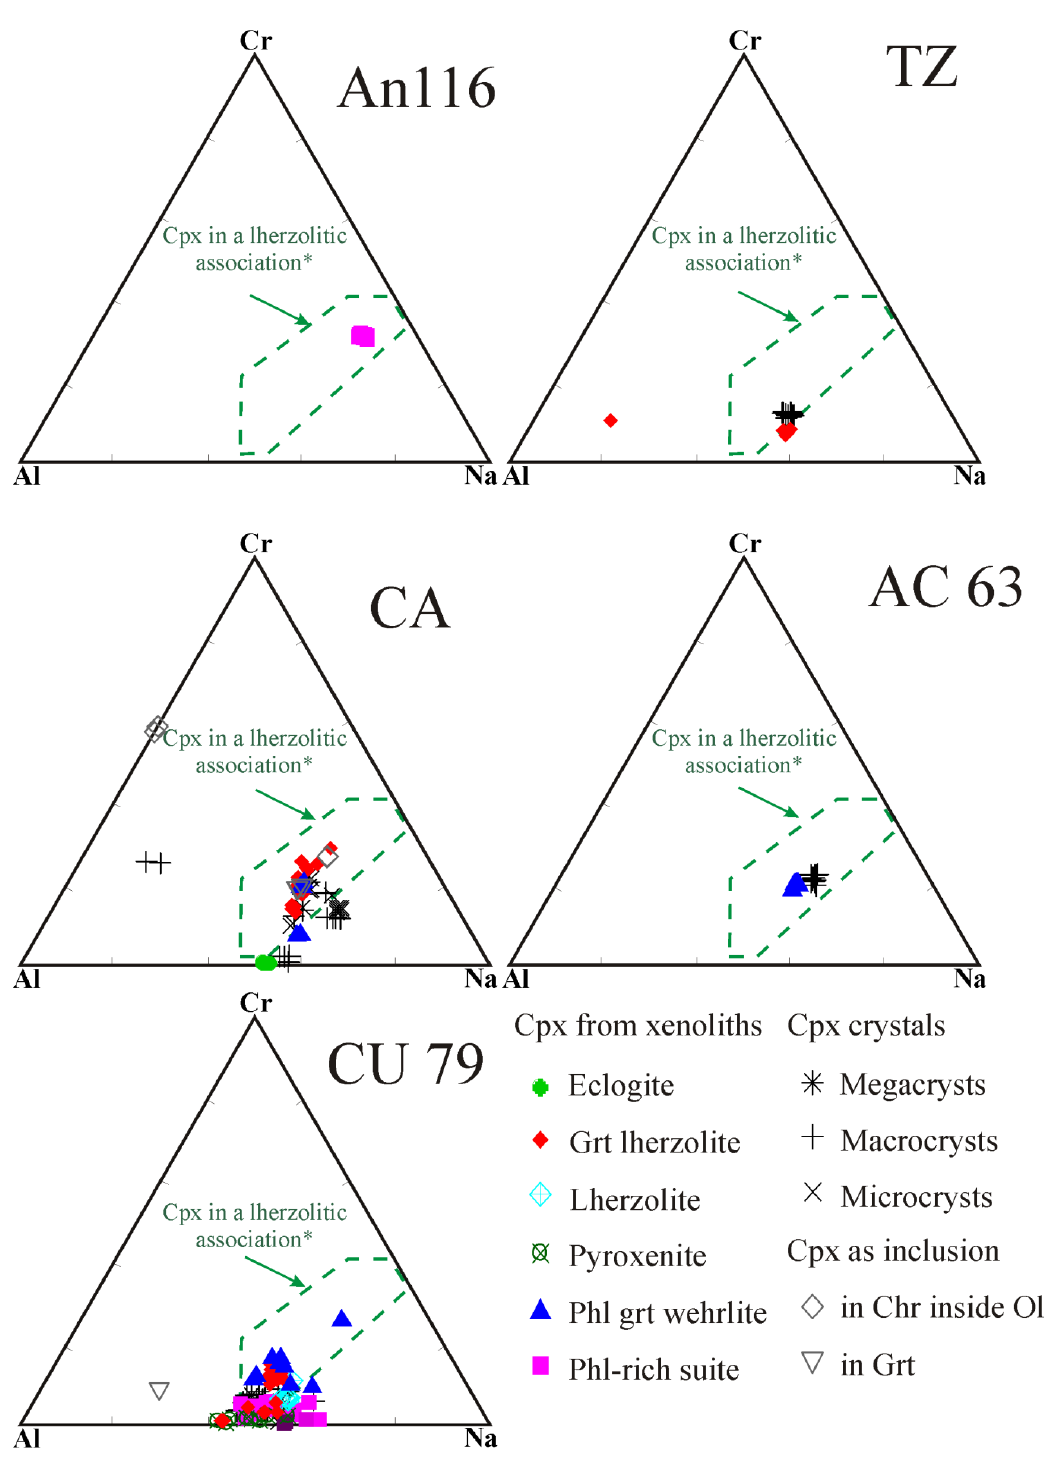
Figure 5. Plot of Al-Cr-Na (apfu) for clinopyroxene from the kimberlites